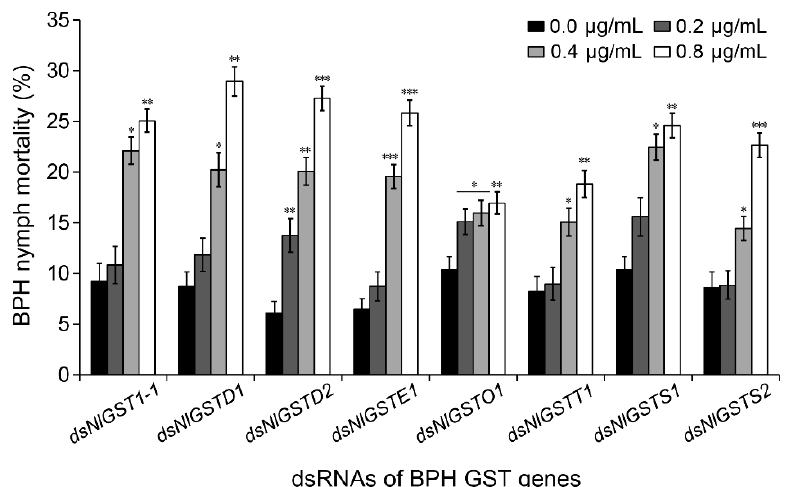
Figure 3. Effect of GST dsRNAs on BPH nymph mortality. The second- or third-instar BPH nymphs were fed with artificial diets containing 0.2, 0.4, or 0.8 ng/µL of each GST dsRNA or 0.4 ng/µL GFP dsRNA (control, without 0.0 ng/µL target gene dsRNA). The nymph mortalities in all the treatments and control were statistically analyzed. The label “ds + gene” represents dsRNA of the corresponding gene. Data represent the means ± SEM from 4 replicates; *, **, *** indicate significance at p < 0.05, 0.01, and 0.001, respectively.